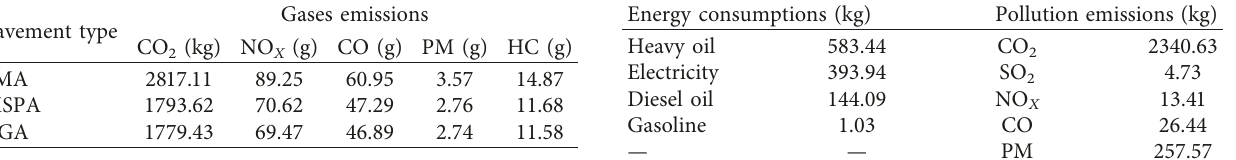
Table 4: Gaseous emissions of constructing 100m 2 asphalt con- crete pavement. Pavement type